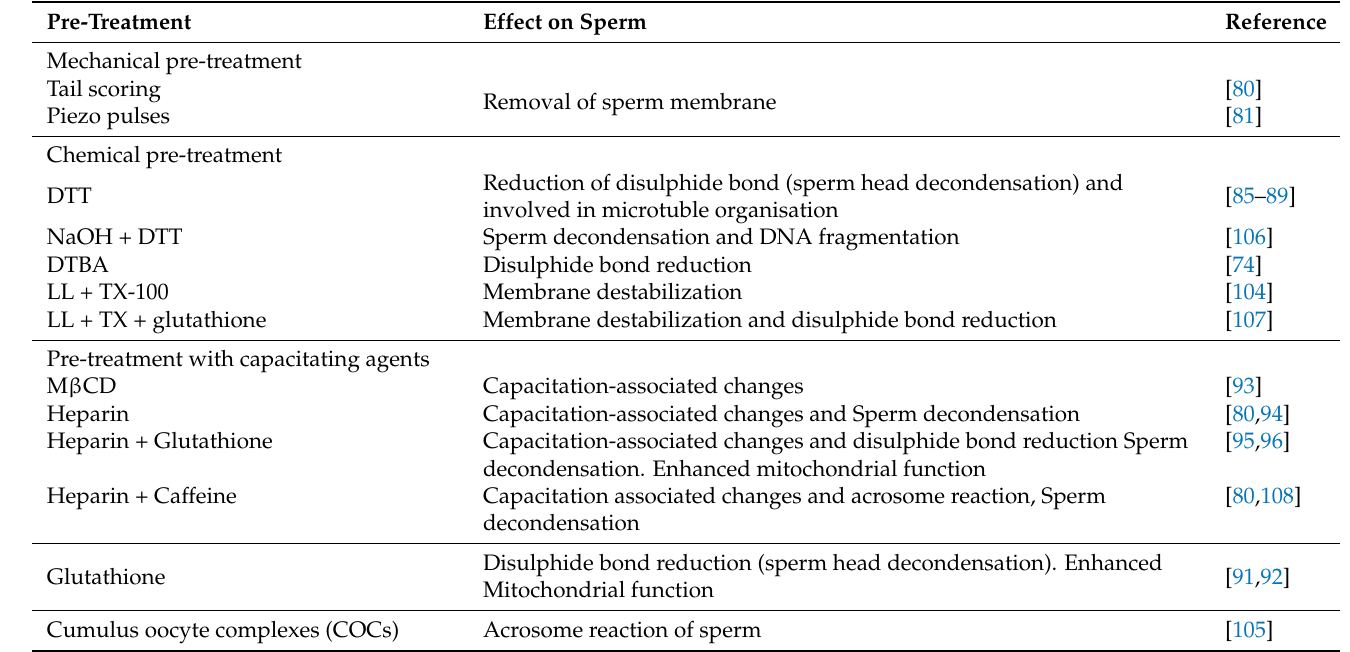
Table 1. Effect of various pre-treatments on bovine